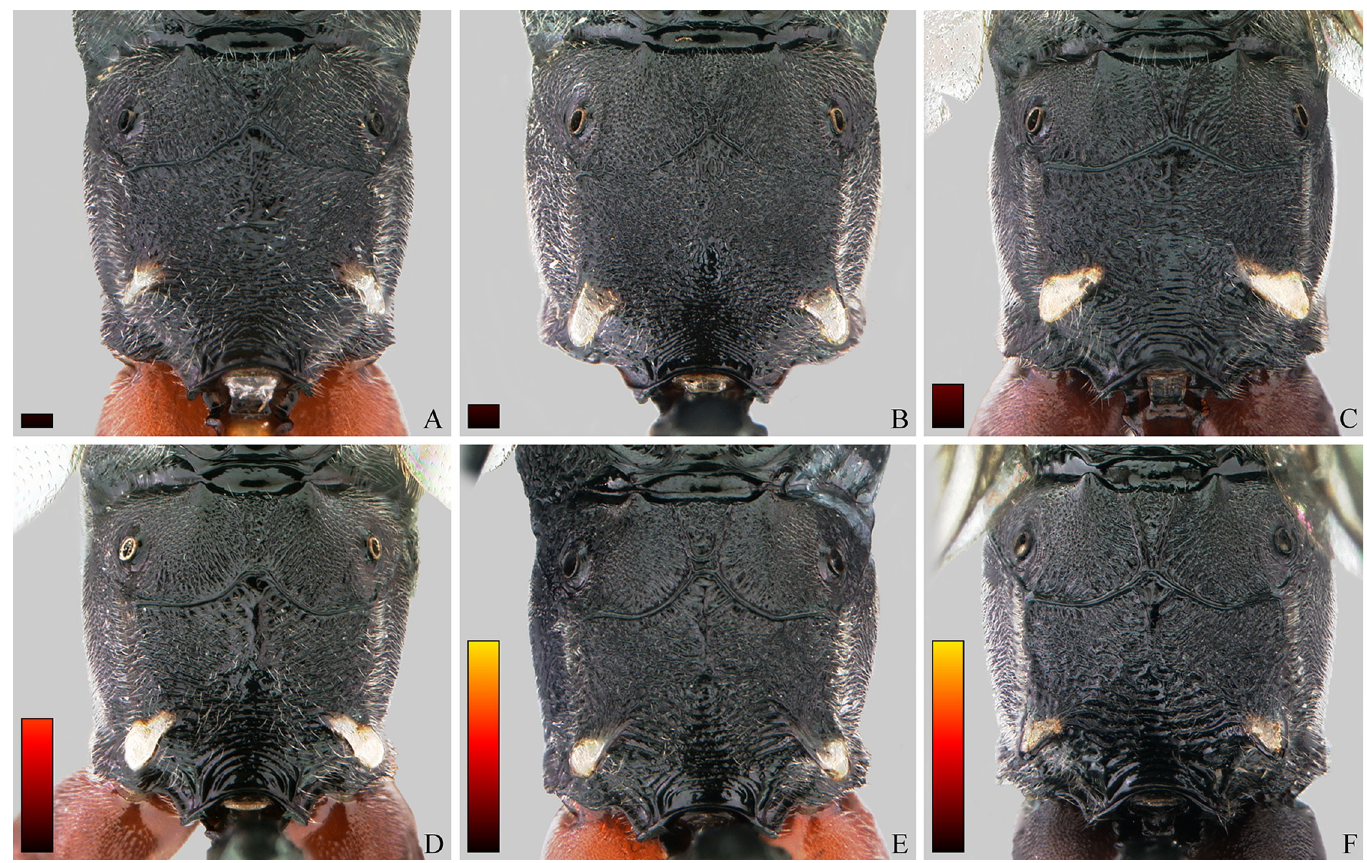
Fig 14. Cryptoxenodon metamorphus sp. nov. Female propodeum, dorsal view. (A) Paratype FAS4613, Alt. 36m, Brazil/PA. (B) Paratype, FAS4603, Alt. 61m, French Guiana. (C) Paratype UFES45548, Alt. 115m, Brazil/BA. (D) Paratype UFES49176, Alt. 354m, Brazil/BA. (E) Holotype FAS1127, Alt. 561m, Brazil/ES. (F) Paratype FAS331, Alt. 561m, Brazil/ES. Bars are proportional to the altitude.